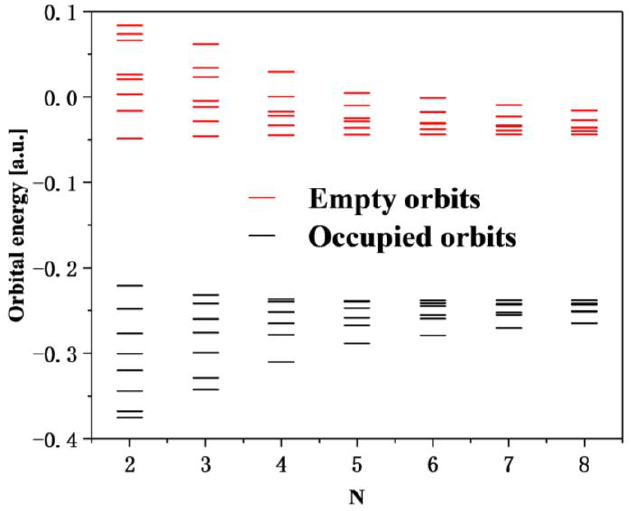
Figure 2. ( a ) OPA spectrum of [2N,2N]CNB. The absorption peak of the absorption spectrum is broadened by a Gaussian function, FWHM = 0.5 eV. ( b ) The relationship between the wavelength and ε of the maximum absorption peaks of [2N,2N]CNB and the size.